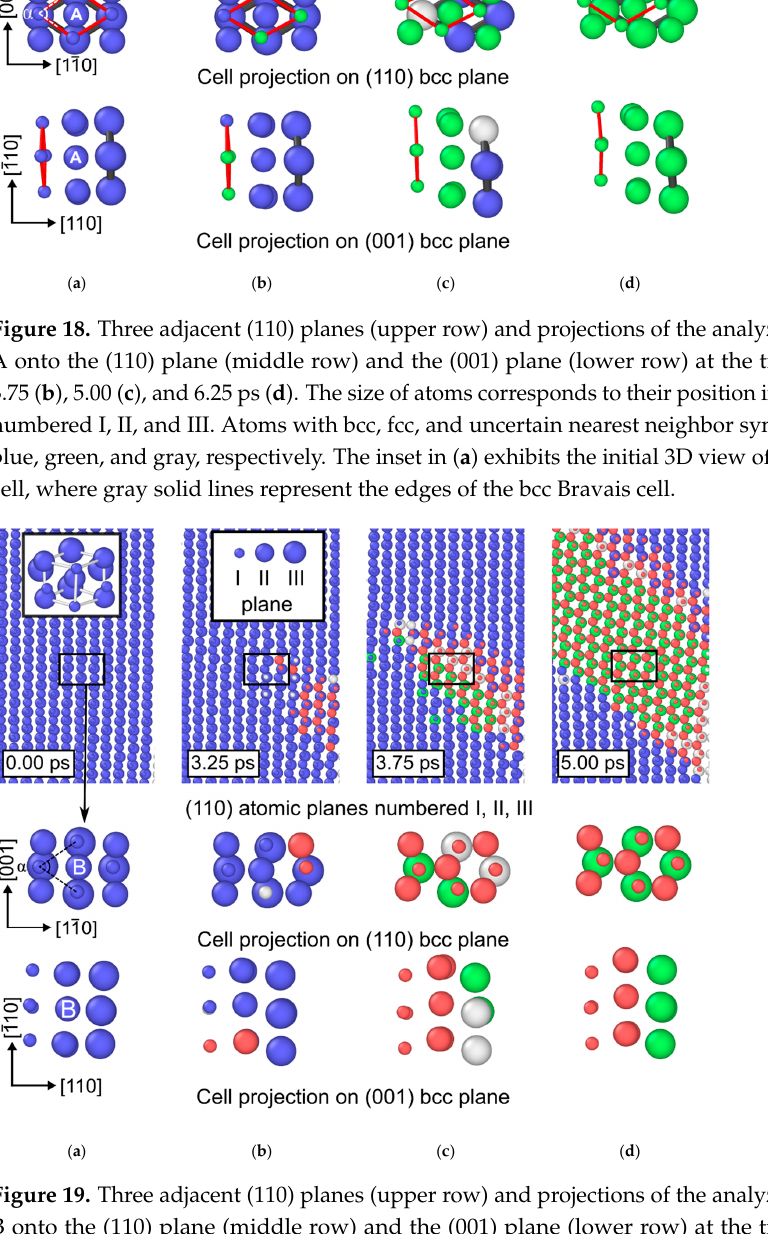
. Figure 20. Time dependences of the Voronoi cell volume, angle α between adjacent <111> directions in the bcc (110) planes, and relative displacement of plane II in the bcc [ 1(cid:3364) 10] direction for atom B. The time axis originates at the strain 4.10%.